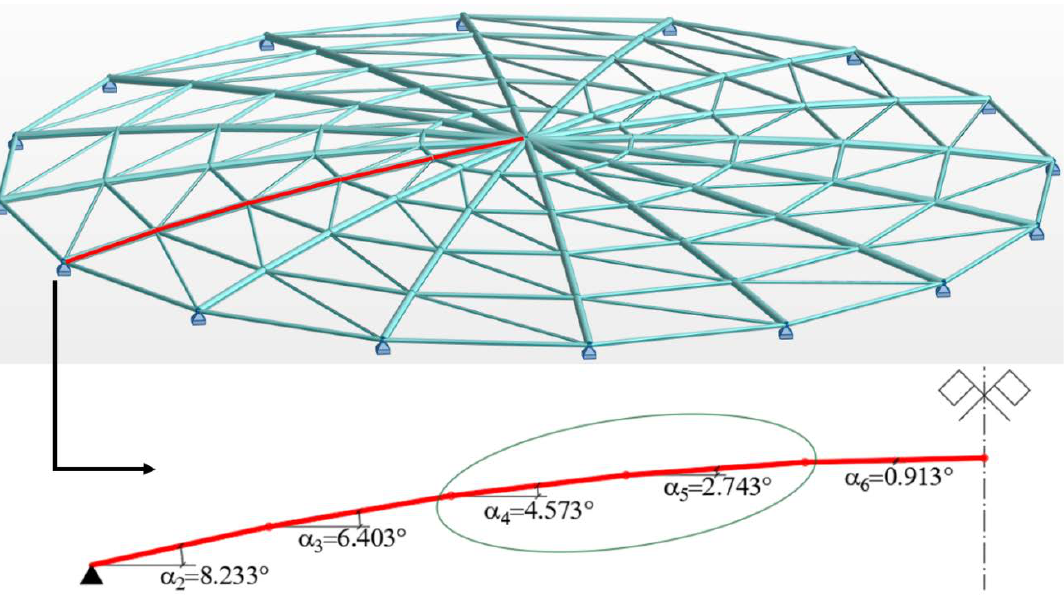
Table 3. Groups of nodes and the corresponding node numbers.